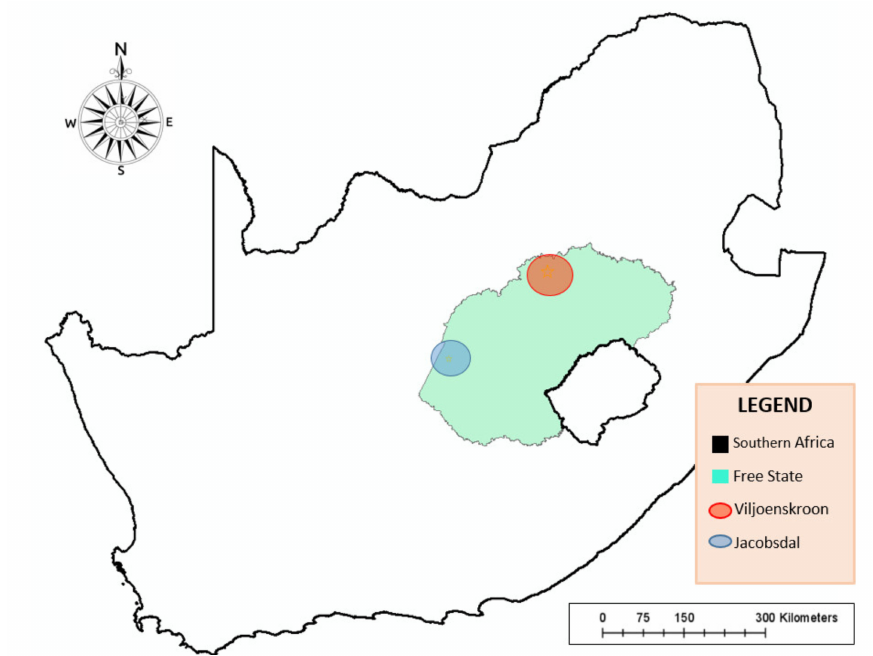
Figure 1. Map showing the location of the study area in the Free State Province of South